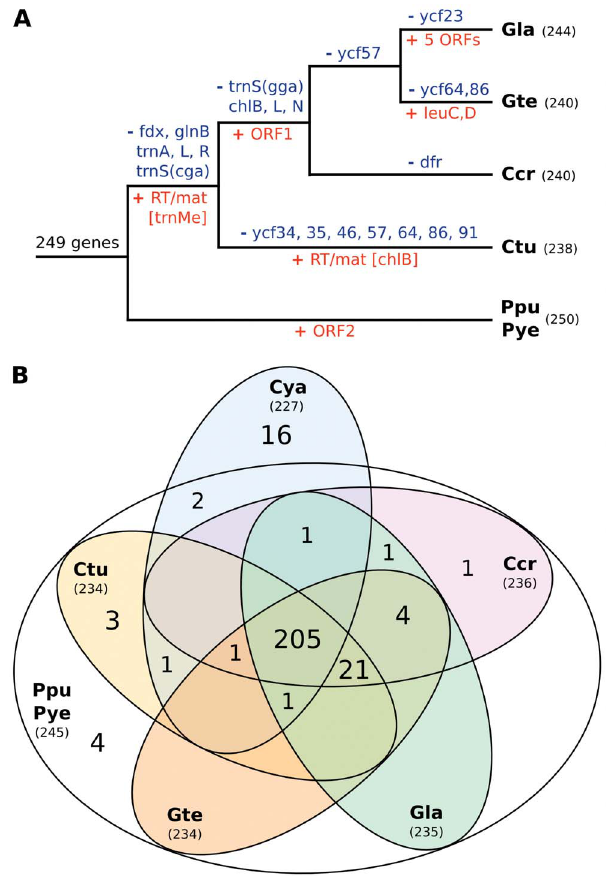
Figure 2. Gene content, gain and loss in red algal plastid genomes. (A) Gain and loss of genes in the florideophyte and Bangiales plastid genomes. Losses of cyanobacterial genes (blue), and gene gains (red) are mapped onto a schematic phylogeny (see Figure 5) using maximum parsimony. Note that losses may have occurred later (independently), whereas gains may have occurred earlier (loss in early- branching lineage) than inferred under this criterion. RT/mat abbre- viates a reverse transcriptase/maturase ORF and the intron-bearing gene is in squared brackets. The absence of magnesium chelatase (chl), tRNA genes (trn), and unknown conserved genes (ycf) may represent outright losses rather than transfers to the nucleus in some cases. (B) Comparison of cyanobacterial gene content in red algal plastids including Cyanidiales. Venn diagram is showing number of cyanobac- terial genes shared among red algal plastid genomes, which represented by bubbles. Ppu Porphyra purpurea , Pye Pyropia yezoensis , Ctu Calliarthron tuberculosum , Ccr Chondrus crispus , Gte Gracilaria tenustipitata var. liui , Gla Grateloupia lanceola, Cya Cyanidiales (sum of genes in Cyanidium caldarium and Cyanidioschyzon merolae